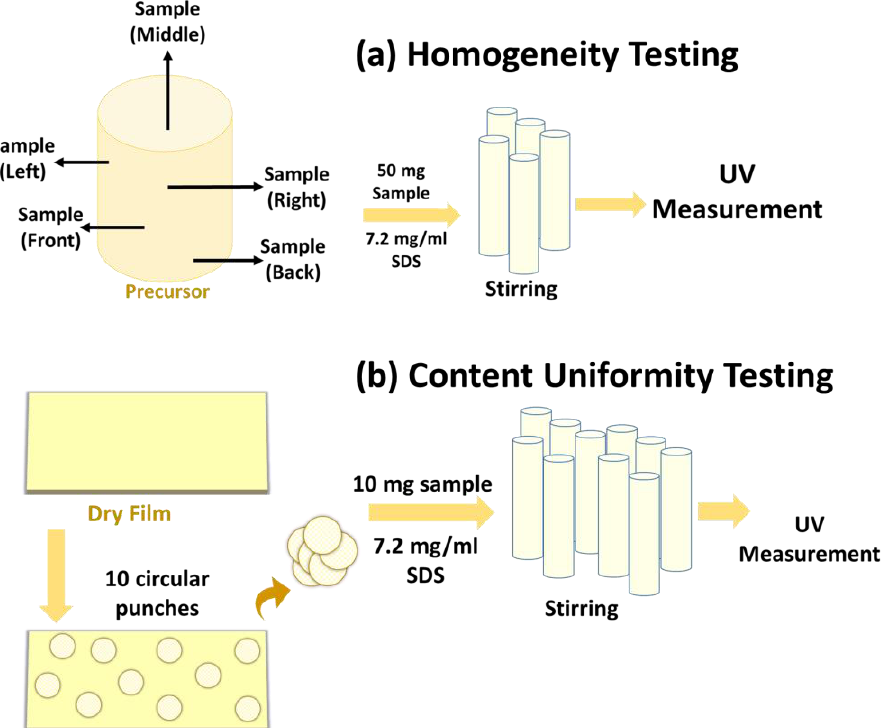
Figure 1. Schematic of the procedures: ( a ) Homogeneity testing from precursor suspension; ( b ) Drug content uniformity (CU) testing from the dried-film.